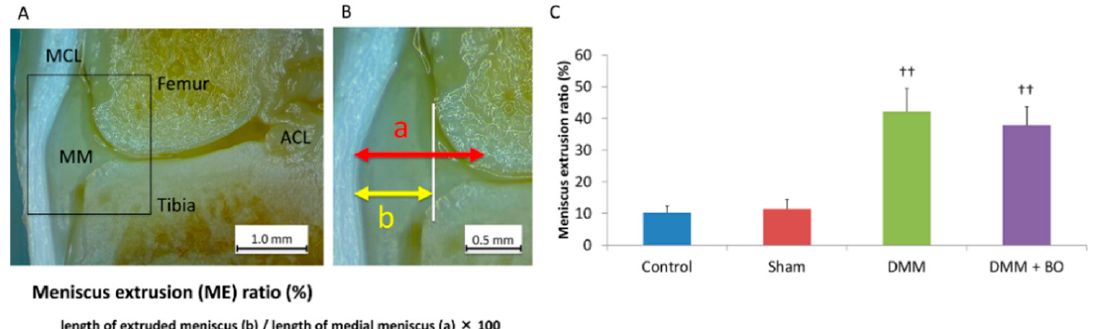
Figure 3. Meniscus extrusion (ME) ratio. ( A ) Coronal view of the medial tibiofemoral compartment. The medial collateral ligament and tibial footprint of the anterior cruciate ligament is confirmed. MCL—medial collateral ligament; ACL—anterior cruciate ligament; MM—medial meniscus. ( B ) Definition of ME ratio. White vertical line indicates the medial edge of the femoral condyle. ( C ) ME ratio; quantitation of the extruded meniscus. Bars show the mean ± SD ( n = 6 in the control and sham groups, n = 5 in the DMM and DMM + BO groups). The stars indicate a significant difference from the control group by the Tukey–Kramer test ( †† p < 0.01 vs. Control).